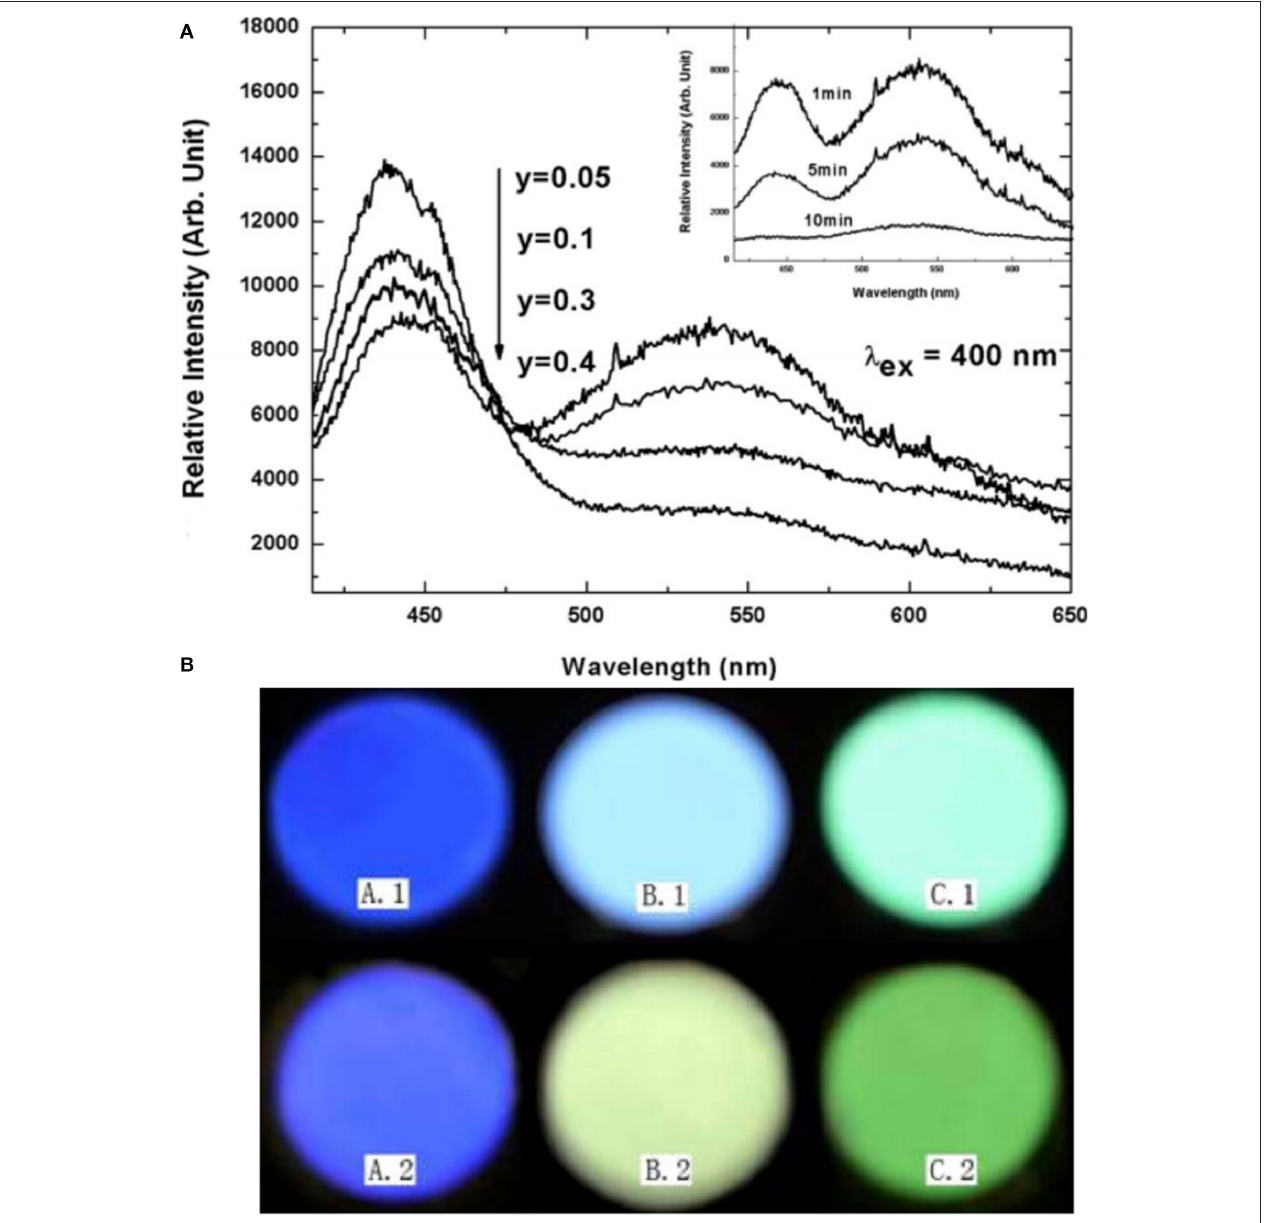
FIGURE 9 | (A) PL spectra of Ca 1 − 3x − y Al 2 O 4 : xEu 2 + , 2xNd 3 + , ySr 2 + ( x = 0.00125, 0.05 ≤ y ≤ 0.4), and the inset shows the LPL spectra of the sample ( y = 0.4) measured at different times (1, 5, and 10min). (B) Photos of PL (above) and LPL (below). A: CaAl 2 O 4 : xEu 2 + , 2xNd 3 + ( x = 0.00125); B: Ca 1 − 3x − y Al 2 O 4 : xEu 2 + , 2xNd 3 + , ySr 2 + ( x = 0.00125, y = 0.4); C: SrAl 2 O 4 : xEu 2 + , 2xNd 3 + ( x = 0.00125). Reproduced with permission from Xu et al. (2009b), copyright 2009, IOP